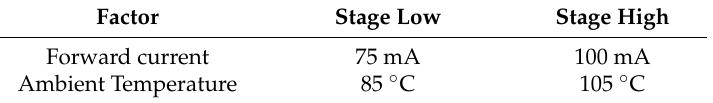
Table 1. Full factorial design of experiments relevant factors and their corresponding stages.